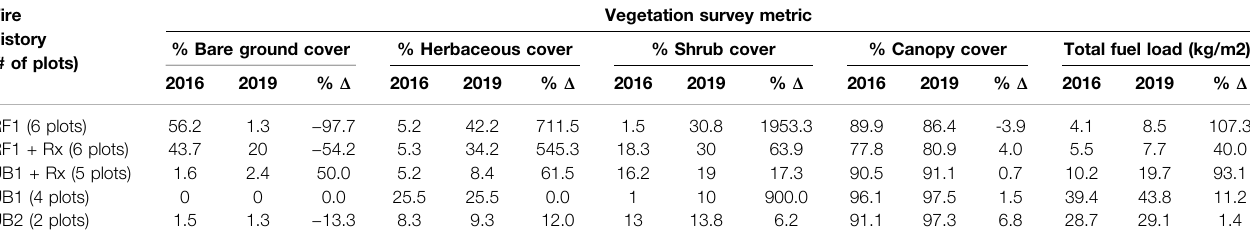
Vegetation survey